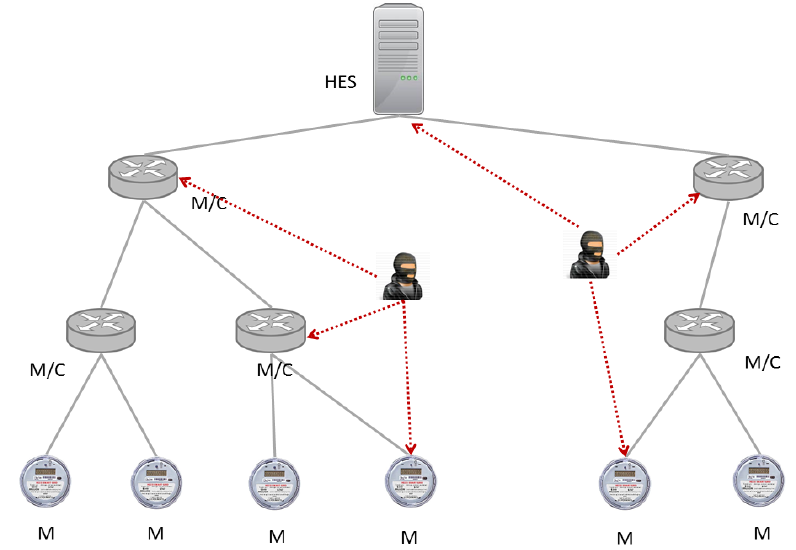
Figure 1. Illustration of the components in the Advanced Metering